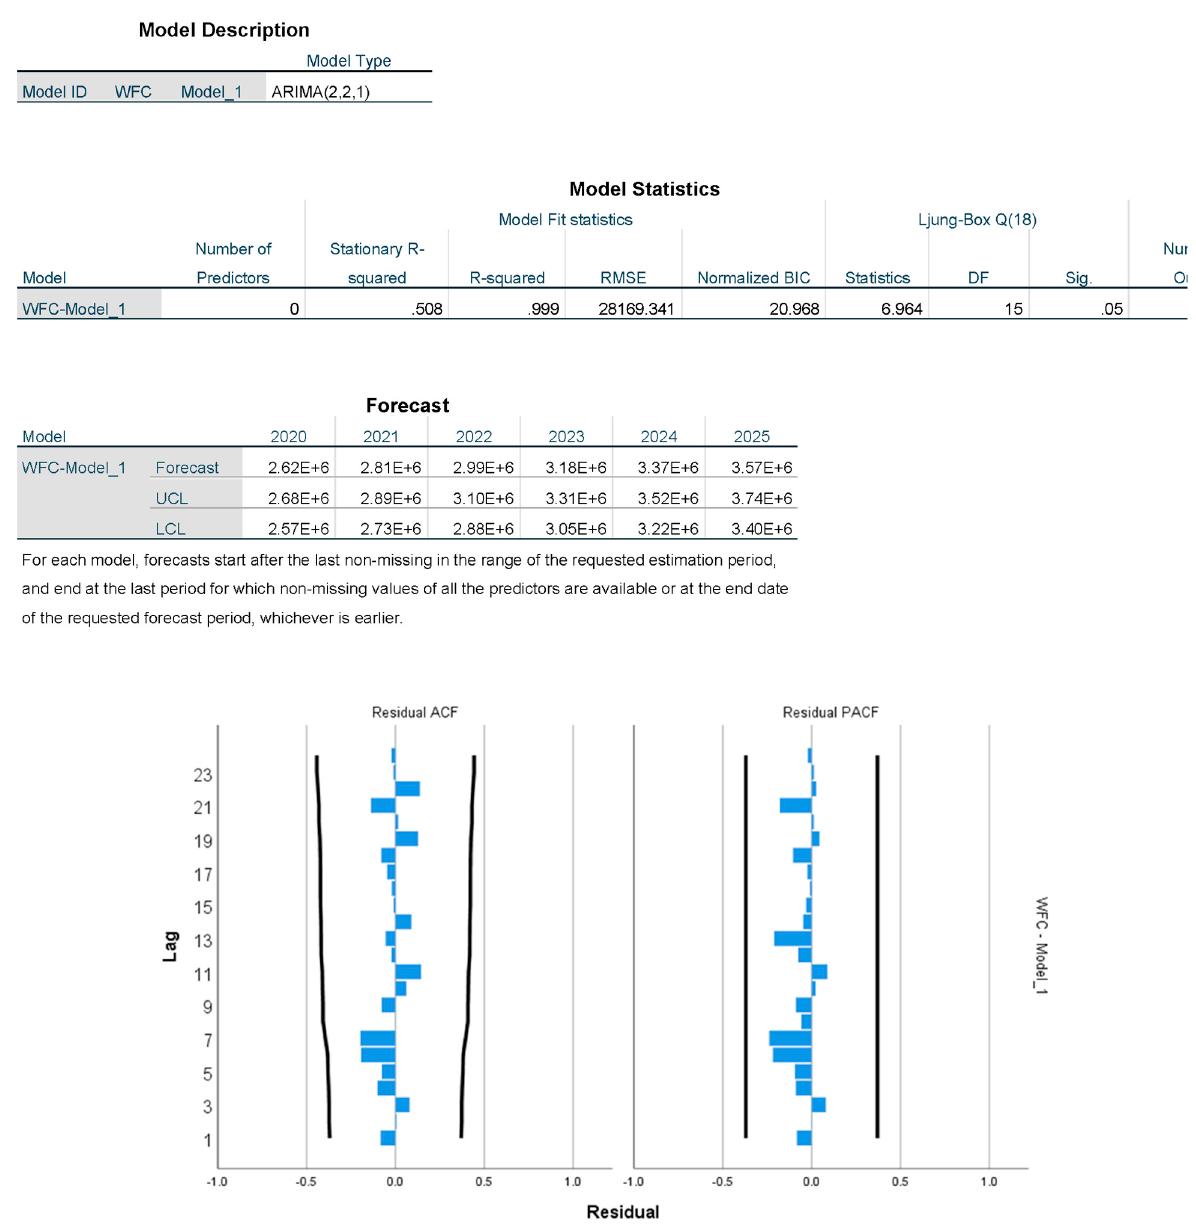
Figure A6. Model (2) forecast in welfare costs.